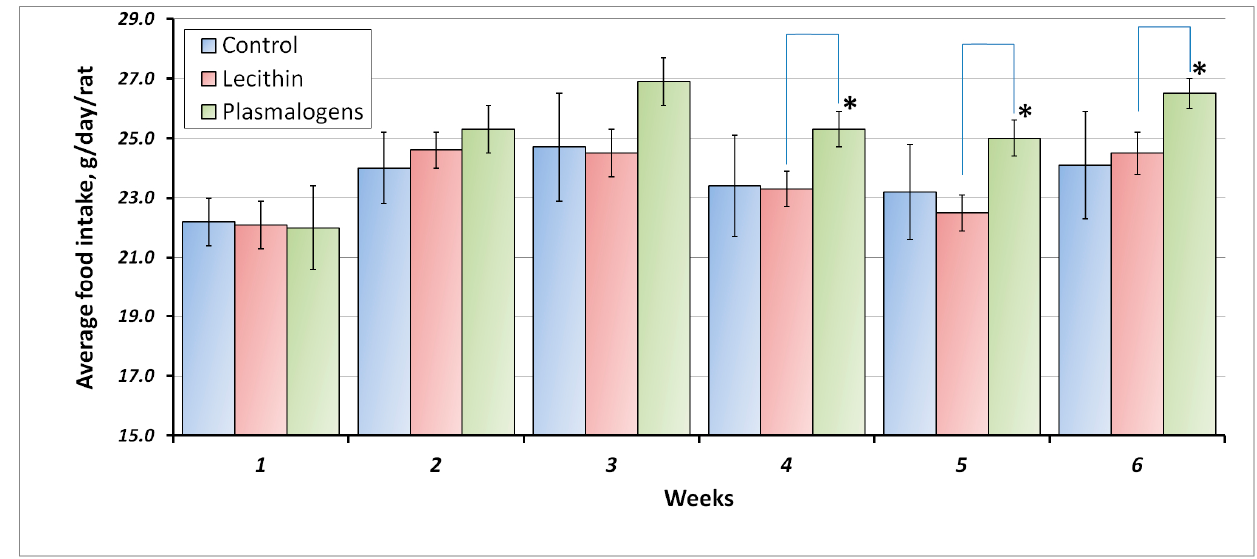
Figure 1. Daily food intake. Values are mean ± SEM of 15 rats per group * one-way ANOVA p < 0.05 versus Lecithin.